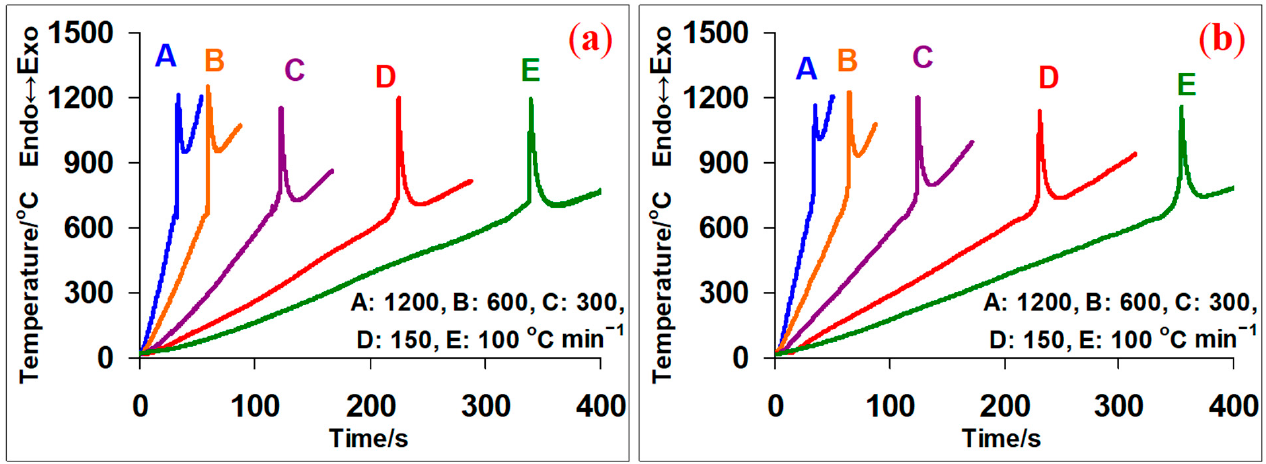
Figure 6. Heating curves of the NiO + WO 3 + 2.5Mg + 1.5C ( a ) and NiWO 4 + 2Mg + 2C ( b ) mixtures for various heating rates.